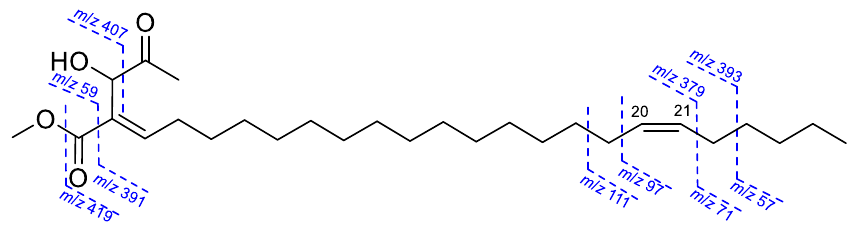
Figure 5. EIMS fragmentation of 7 .